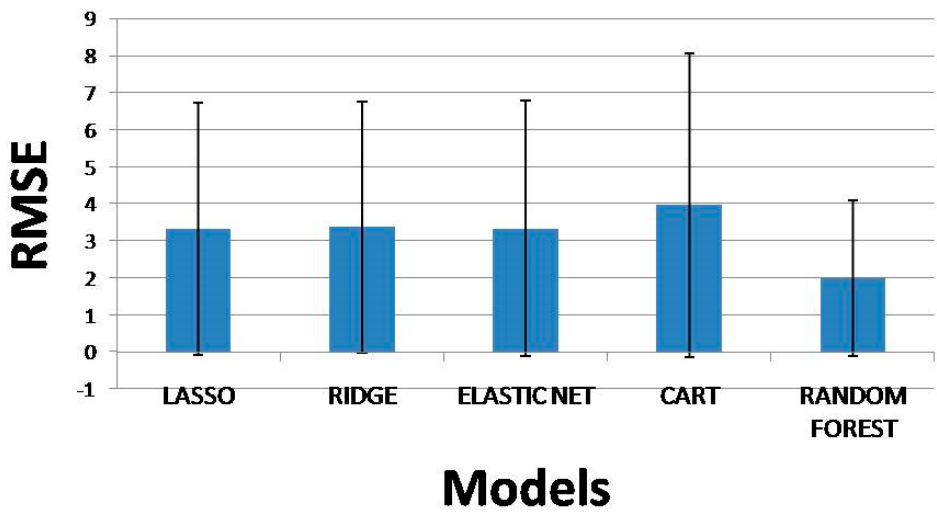
Figure 3. Comparison of the five models in the regression task on the original dataset and 70%/30% training/test set split. Table 2. Model performances, as MAE, in the regression task for the original dataset under the 70/30% training/test set split.